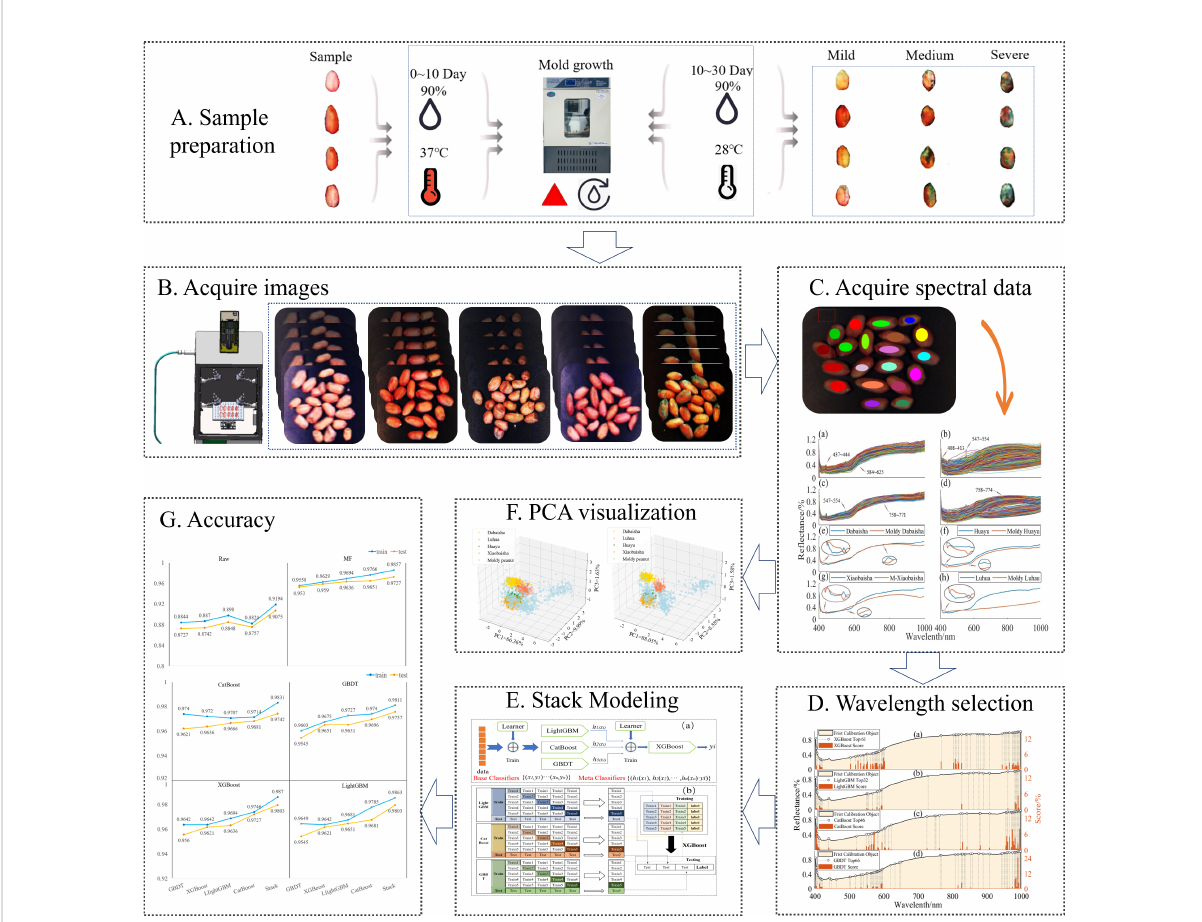
FIGURE 1 Flowchart of the main steps in the detection of peanut seeds by hyperspectral imaging